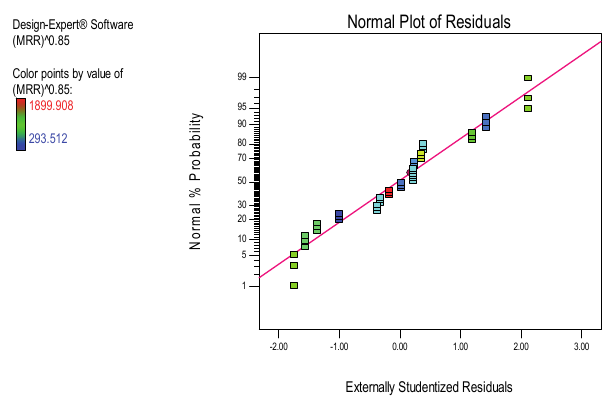
Fig. 8. Normal plot of residuals for